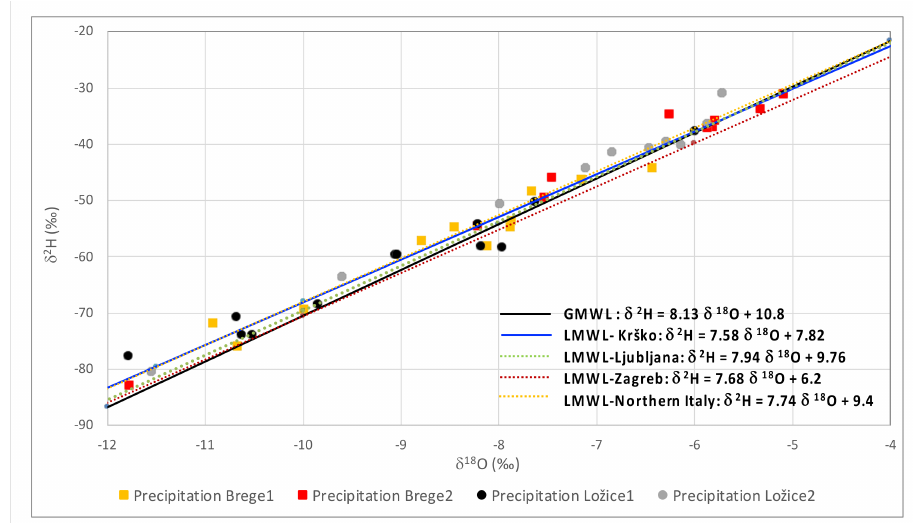
Figure 4. δ 18 O and δ 2 H in precipitation before (number 1 next to sample name) and after (number 2 next to sample name) the filling of the accumulation basin for the HPP Brežice.